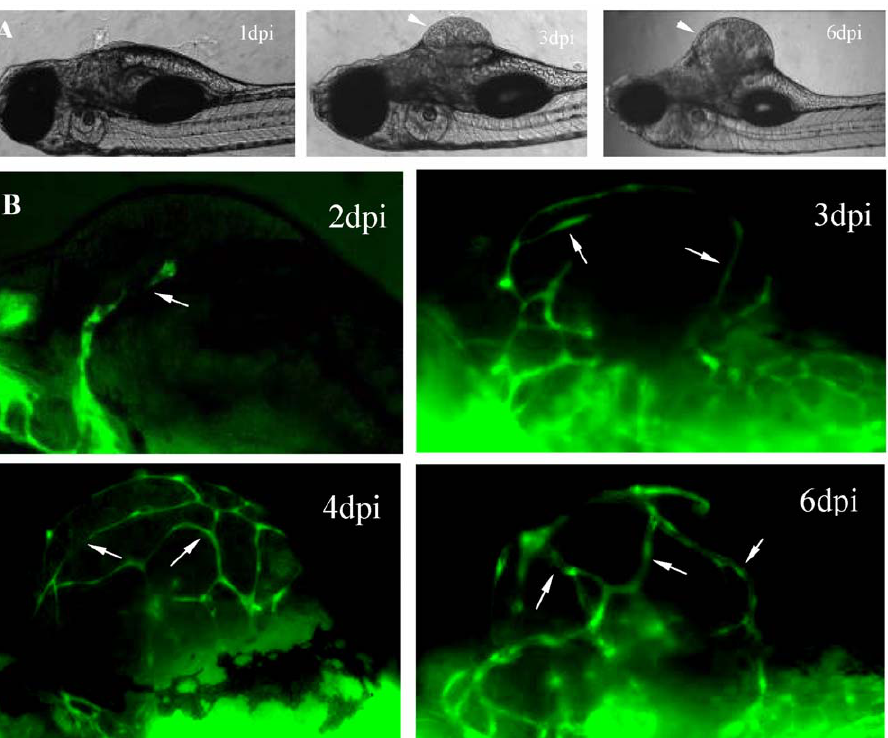
Figure 2. Dynamical observations of aniogenesis in B16 xenografts. The established microtumors (A, 3dpi and 6dpi panels) in zebrafish larvae are indicated by arrowheads. Neo-vessels are indicated by arrows (B).